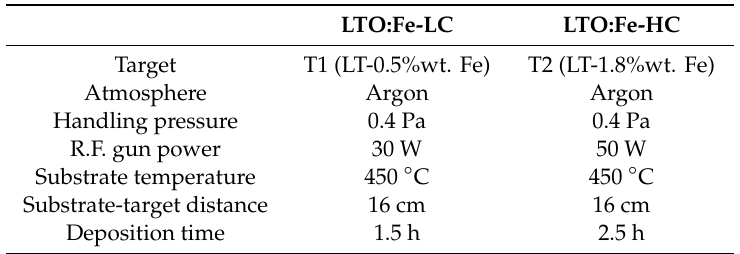
Table 1. Deposition conditions of LTO:Fe-LC and